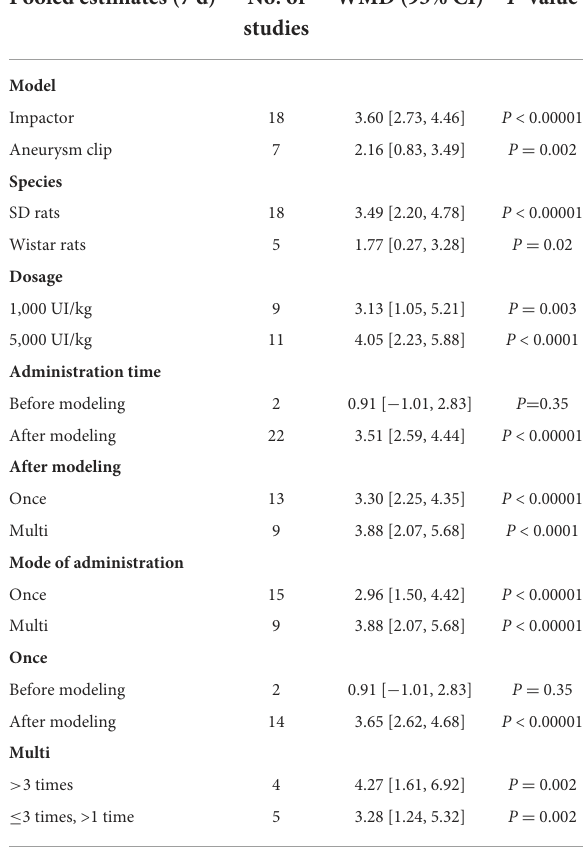
TABLE 3 Subgroup analysis of BBB